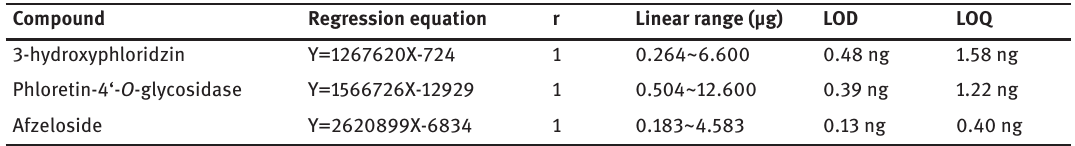
Table 1: The linear regression equations of three compounds. Compound Regression